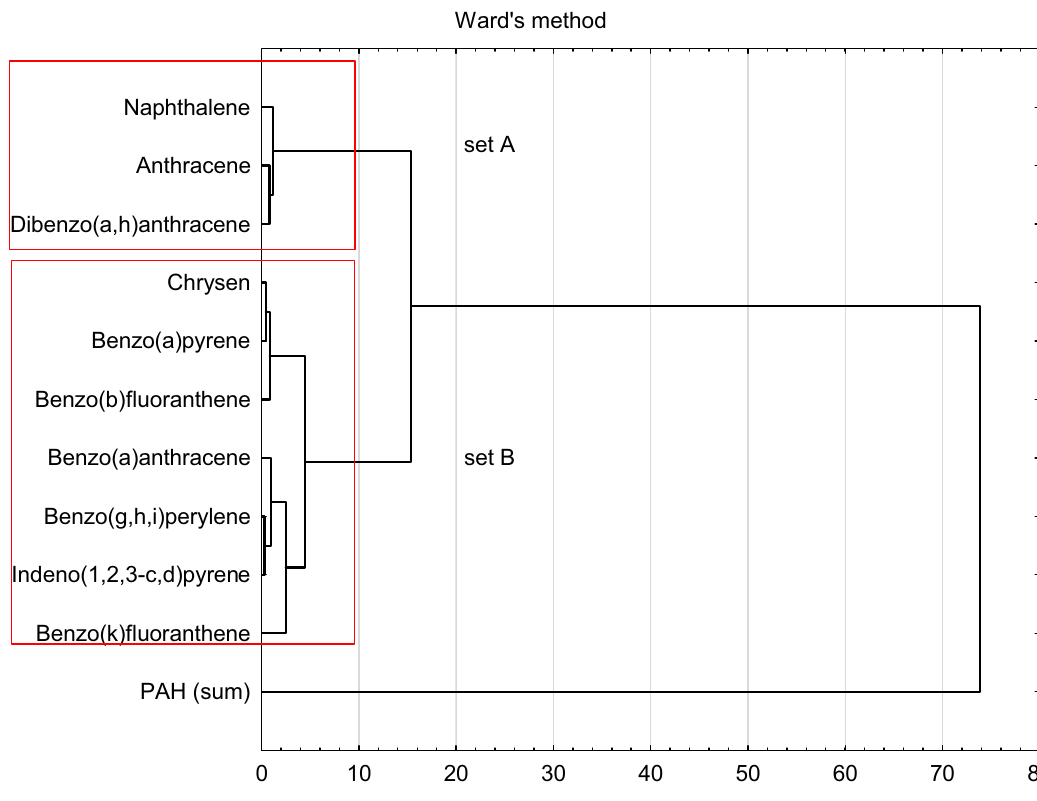
Figure 6. Cluster analysis for the tested samples in terms of the distribution of individual hydrocarbons.